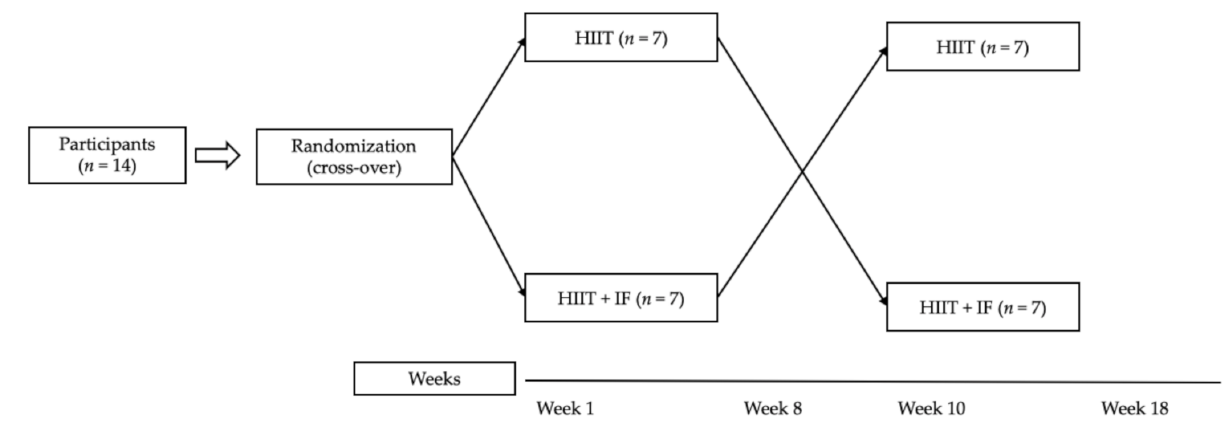
Figure 1. Flow diagram of cross-over study